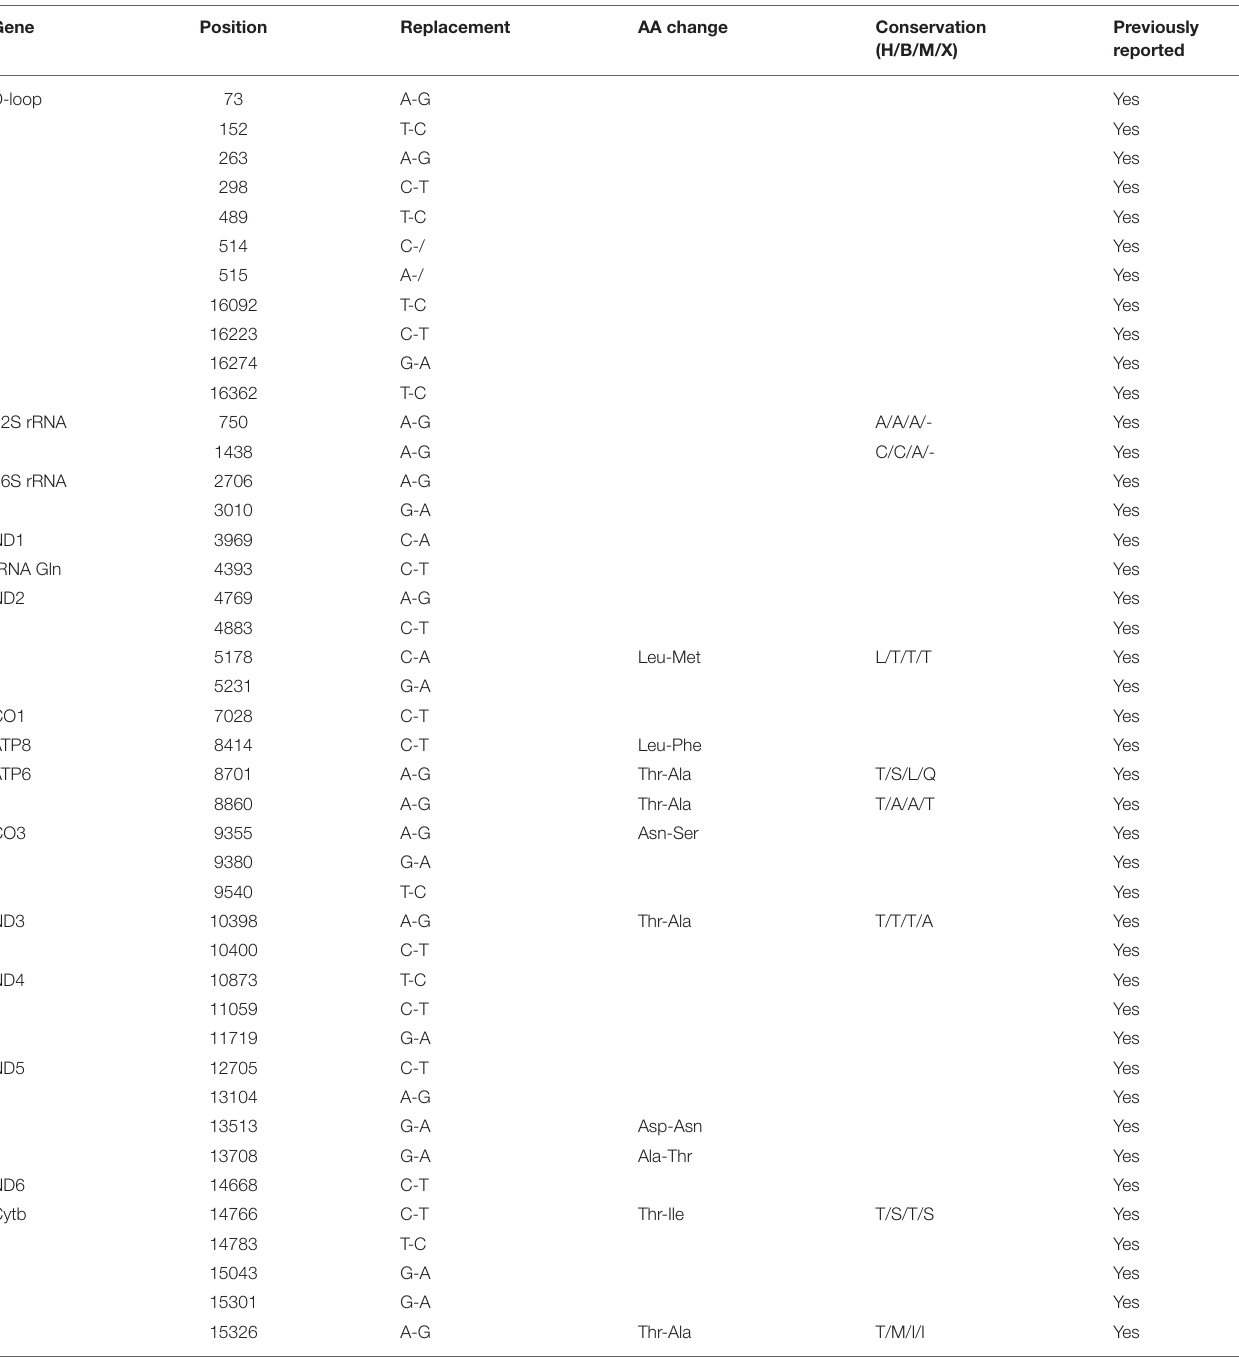
TABLE 1 | mtDNA variants in a Chinese family with Leber’s hereditary optic neuropathy. Gene Position Replacement AA change Conservation